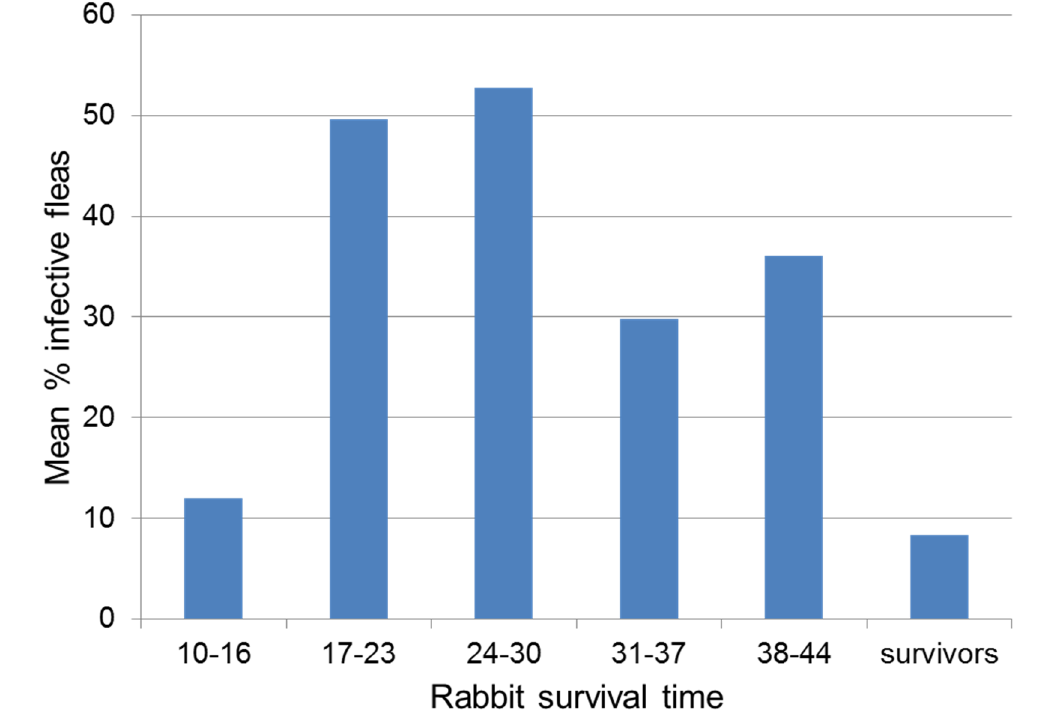
Figure 3. Transmission of MYXV by fleas 8-28 days after infection with viruses of different virulence grades. Fleas were combed from rabbits infected with viruses of virulence grade 1, 3A, 3B or 5, and tested for transmission by feeding on an uninfected rabbit. Rabbits have been grouped by survival time irrespective of the virus with which they were infected. The average percentage of infective fleas between days 8 and 28 after infection is shown for each group. Data are from